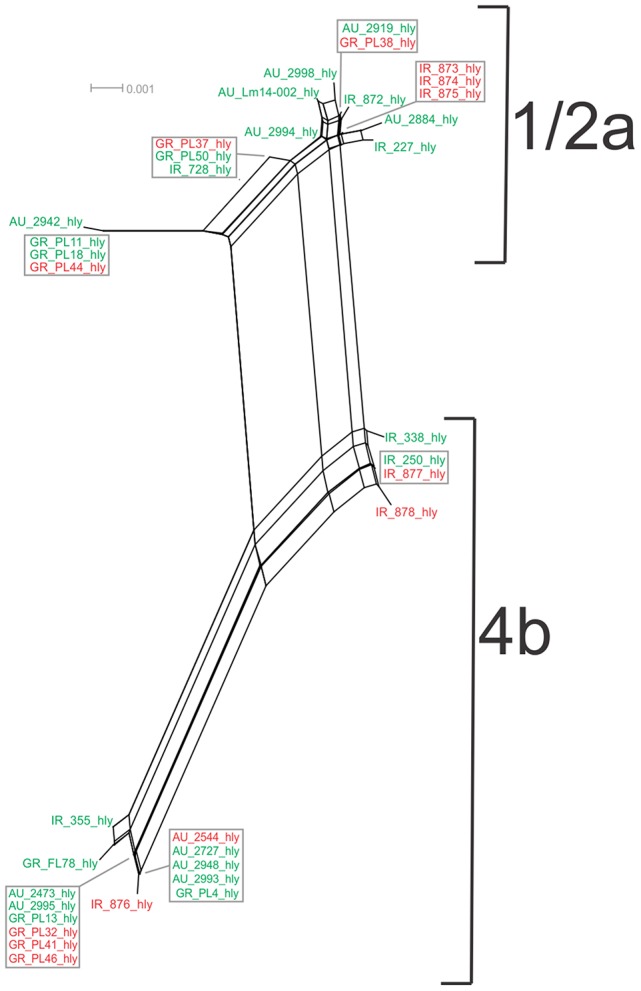
Phylogenetic network applied to virulence gene hly using the Neighbor-Net algorithm. L. monocytogenes strains represented food environment isolates (green color) or clinical isolates (red color), isolated in Ireland (IR), Greece (GR), and Australia (AU). Strains clustered together in a box represent identical nucleotide sequence.